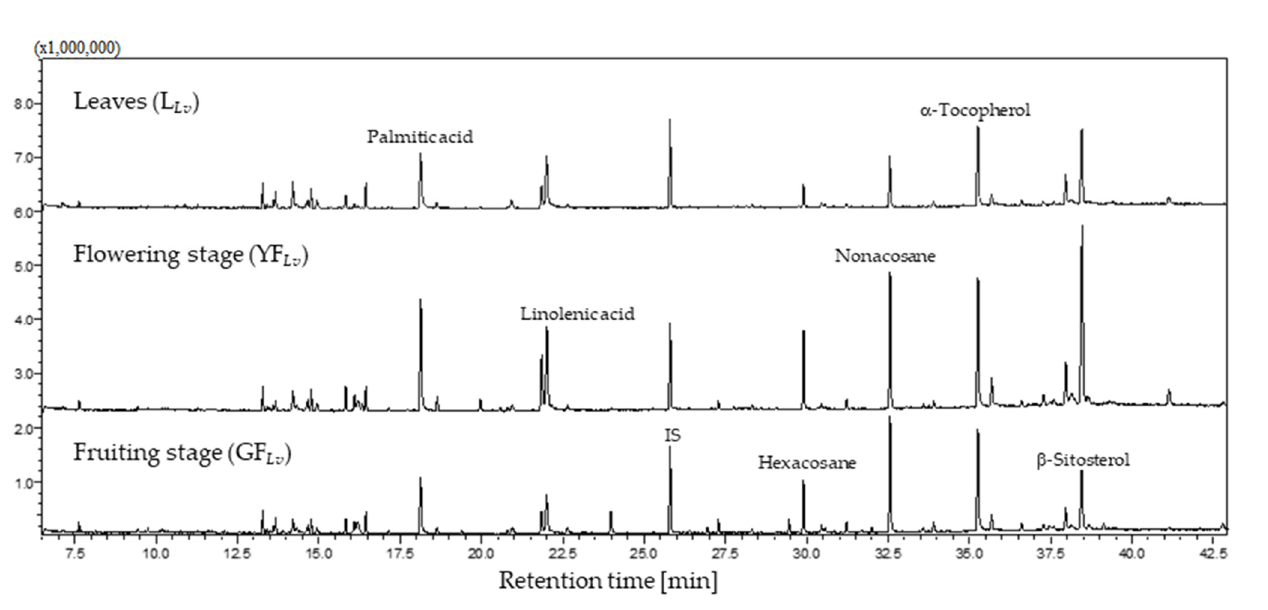
Figure 1. Total ion chromatogram of the L. vulgare hexane extract.